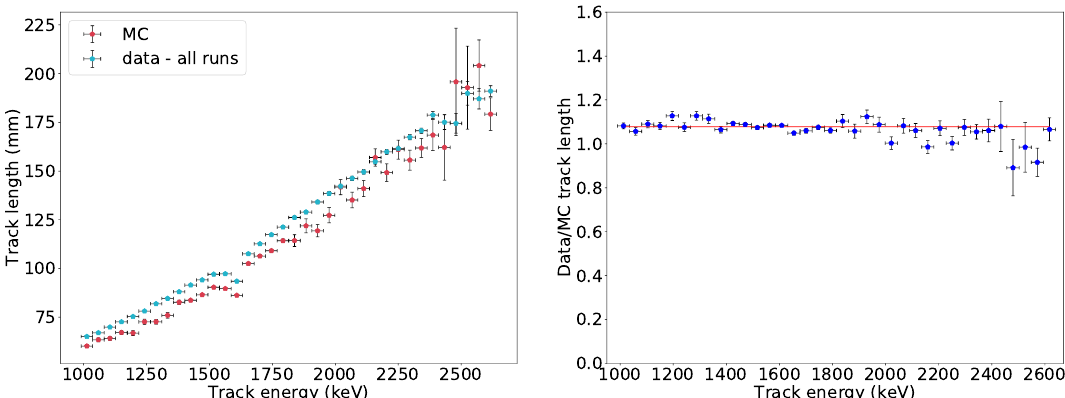
Figure 6 . Track length as a function of the track energy for data and Monte Carlo. The left panel shows the average value for each bin, while the right panel shows the ratio between data and Monte Carlo and a linear (cid:12)t to the